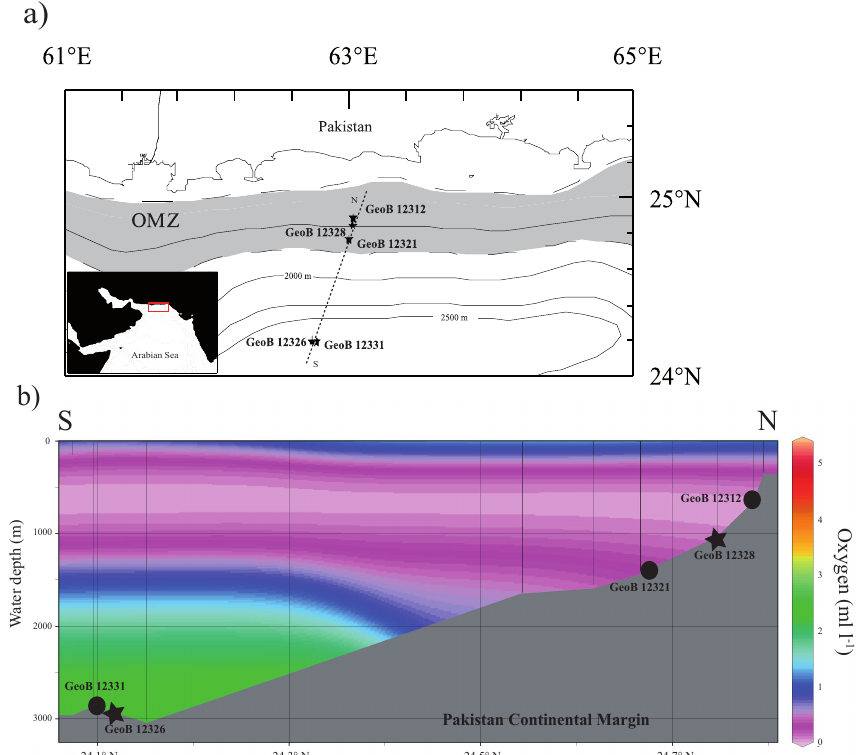
Fig. 1. Map showing ( a) sample locations along the Pakistan continental margin in relation to the intermediate depth oxygen minimum zone (OMZ) ( b) water column oxygen concentrations, as measured by CTD profiling, compared to the sample locations. Circles indicate multi-core samples, and comprise the OMZ transect, and stars denote push core locations, which comprise the two seep transects.